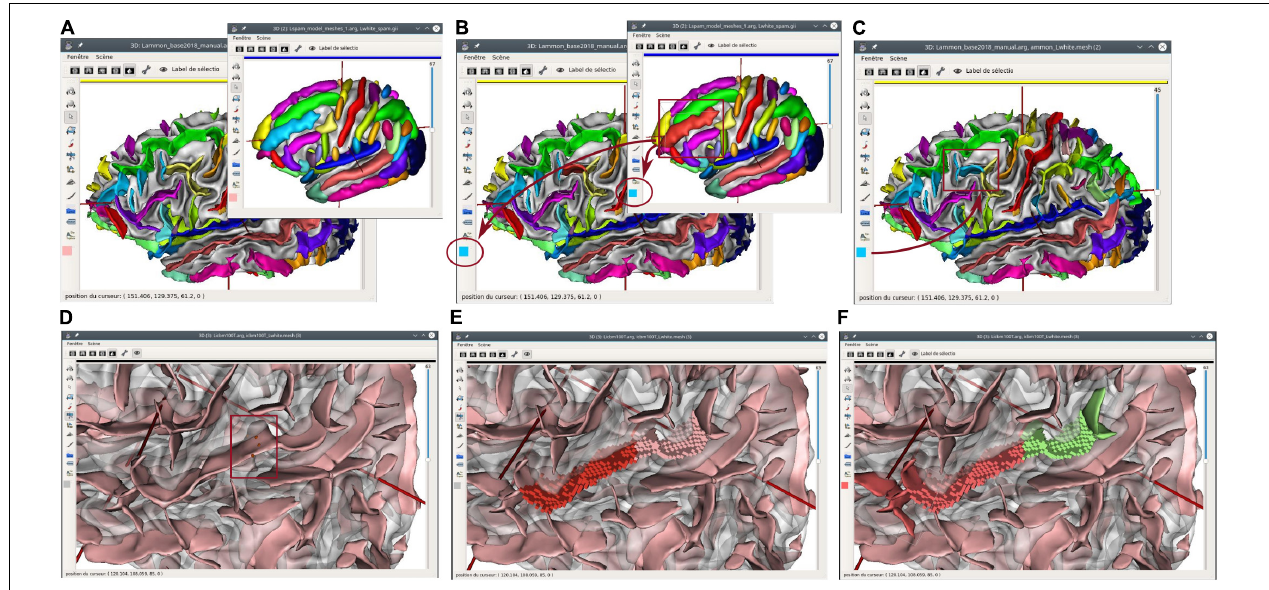
FIGURE 4 | Structural edition capabilities in Anatomist . Top: copy/paste label operation. (A) A sulcal graph (left hemisphere) and a sulci model representation are displayed in Anatomist . (B) The middle frontal sulcus is selected on the model, and its label copied; its cyan blue color appears on the lateral bar of all views. (C) A fold is selected on the subject sulcal graph, and the label is pasted on it; its color switched from yellow (intermediate pre-central sulcus) to blue (middle frontal). Bottom: fold cut and split operation. (D) An unlabeled sulcal graph is displayed; we want to split a large fold belonging to both the superior temporal sulcus, and the anterior ascending terminal branch of this sulcus. In “fold split” mode, we draw a few points materialized by red bullets (inside the red rectangle); (E) the cut operation follows a line going through selected points and splits the fold graph node into two new ones. Mesh representation is replaced with a simpler “voxels list” representation until meshing is processed again; (F) the new folds are labeled using the copy/paste